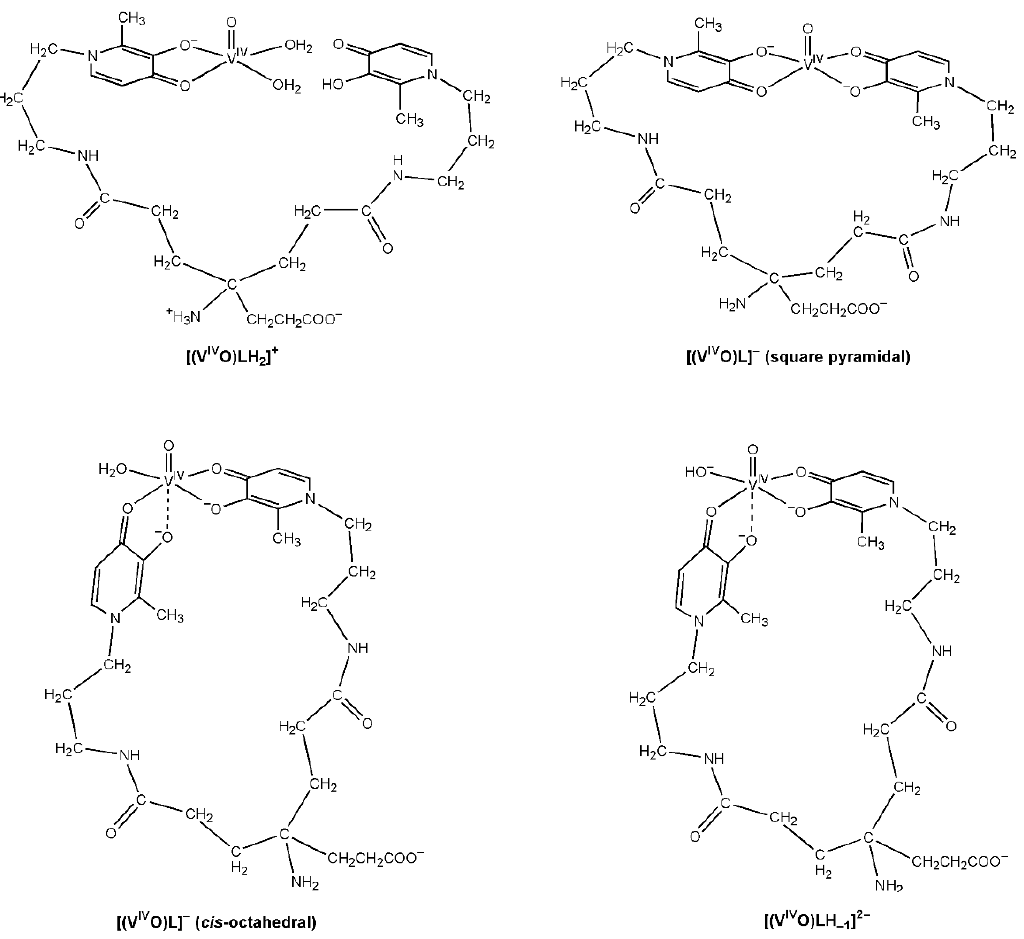
Figure 7. Molecular drawings of the V IV O 2+ species with the ligand KC21 based on the solution studies.